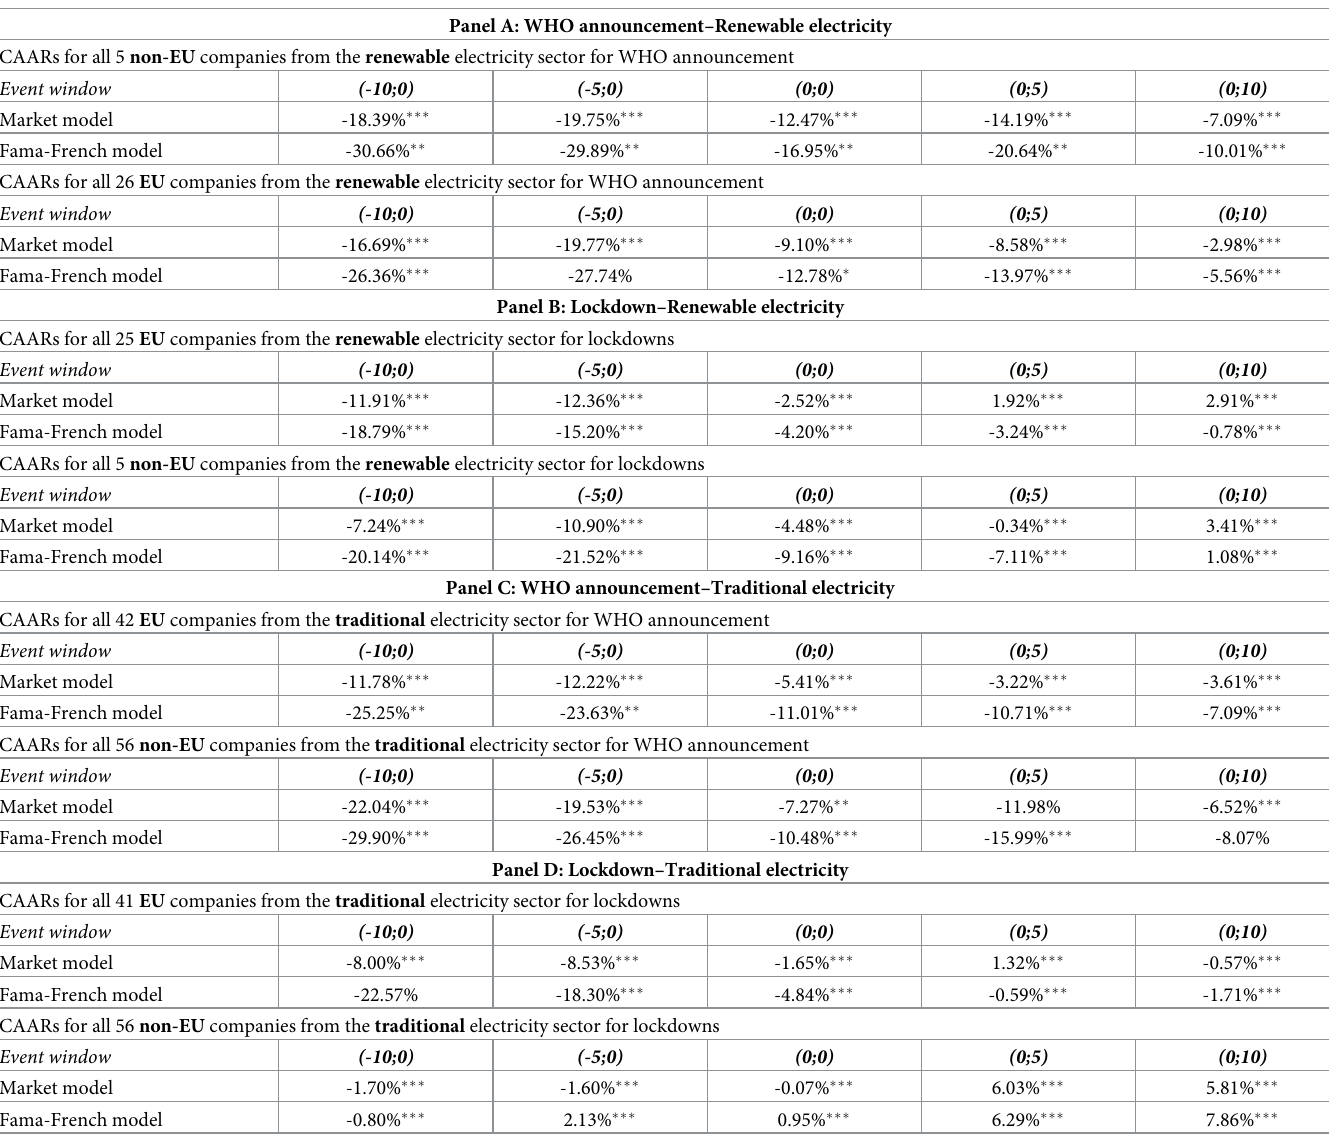
Table 1. Cumulative average abnormal returns for the renewable electricity sector and traditional electricity sector in the EU countries and non-EU countries for WHO announcement and lockdown. Panel A: WHO announcement–Renewable